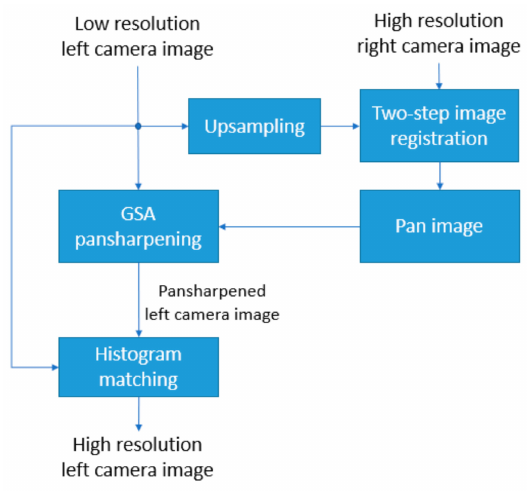
Figure 2. Block diagram of the pansharpening-based image enhancement